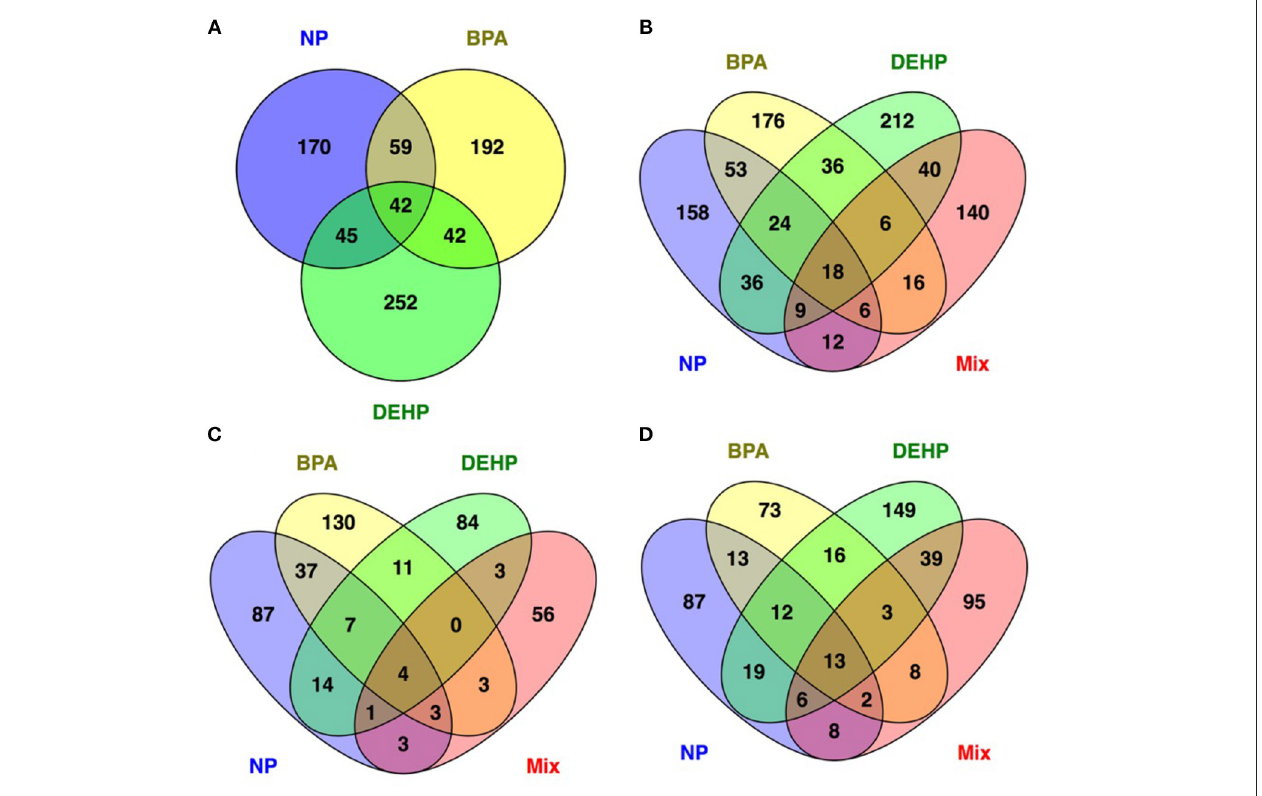
FIGURE 3 | Venn diagram showing the number of unique and common differentially regulated genes in male FHM hepatic tissue affected by NP, BPA and DEHP exposure (A) as well as mixture (B) . (C,D) show the upregulated and down regulated genes respectively. The Venn diagrams reveal 42 genes commonly modulated by individual treatments (A) and 18 genes regulated by all three compounds and their mixture (B) . Among these 18 genes 4 of them upregulated (C) and 13 of them inhibited (D) by all four treatments.